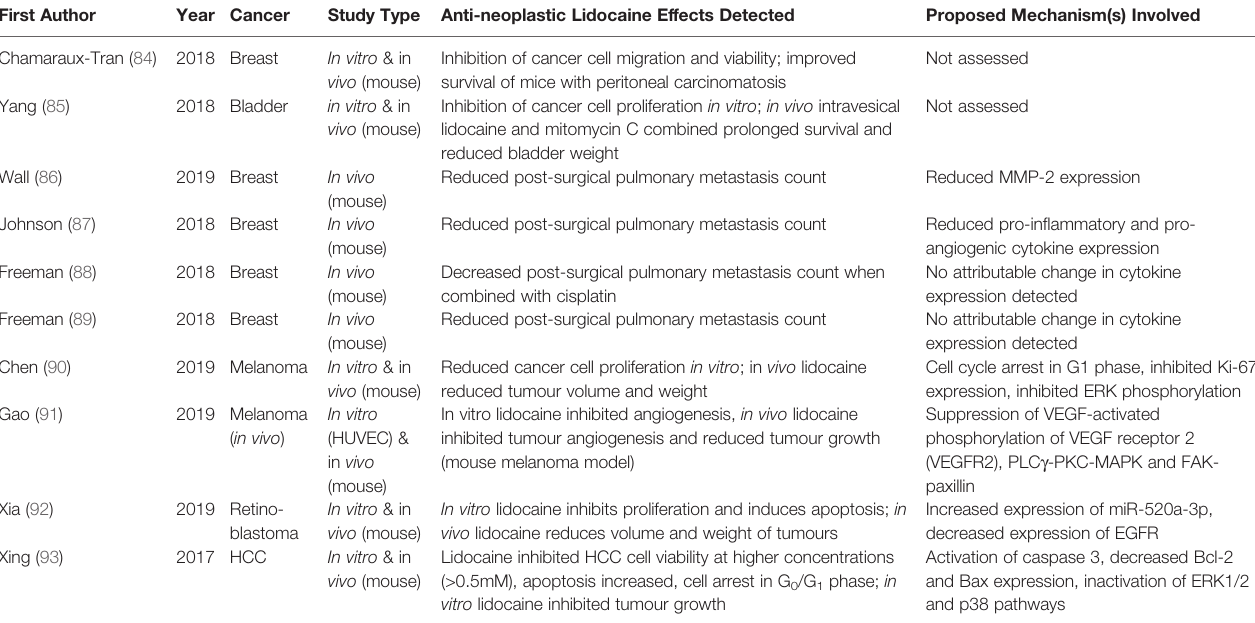
TABLE 2 | Selected in vivo studies examining the effects of lidocaine treatment on cancer progression, metastasis or